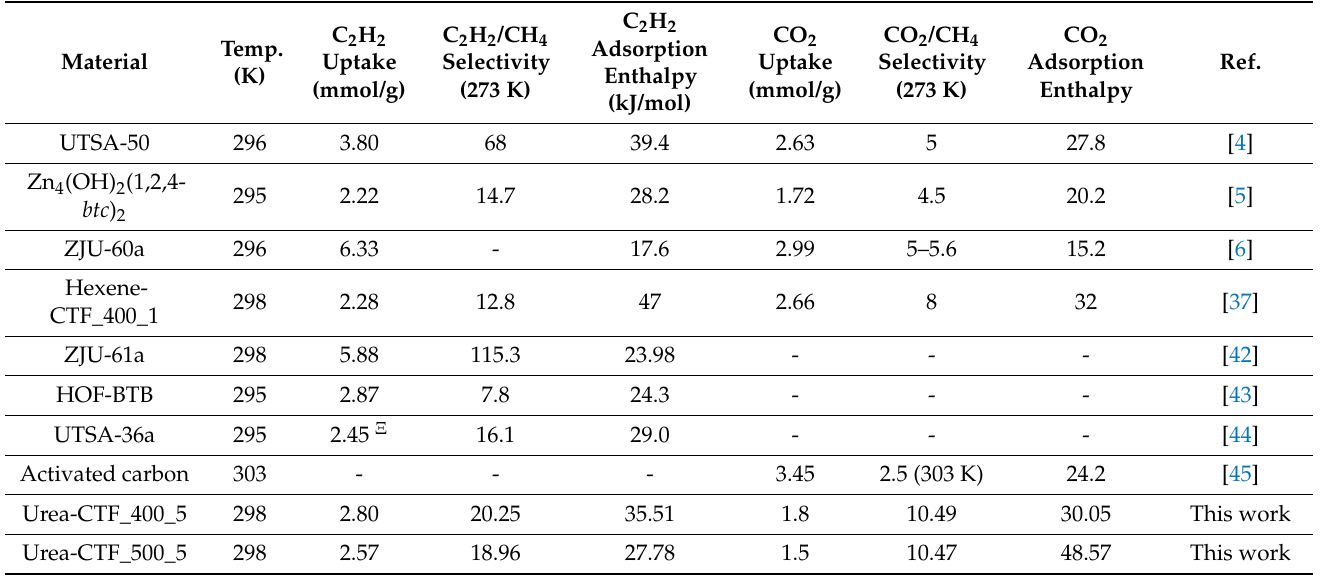
Table 1. Comparison of urea-CTFs with other materials for C 2 H 2 /CH 4 and CO 2 /CH 4 selectivities and adsorption enthalpies.